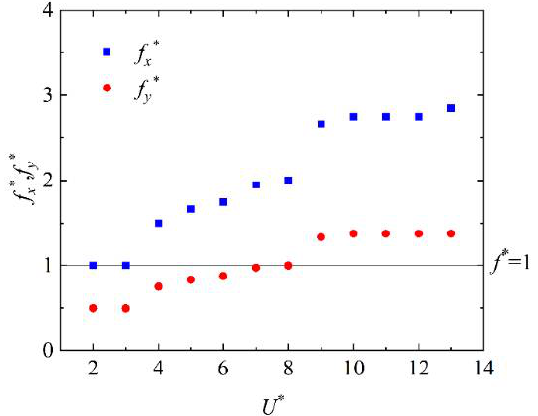
Figure 11. Vibration frequency versus reduced velocity.